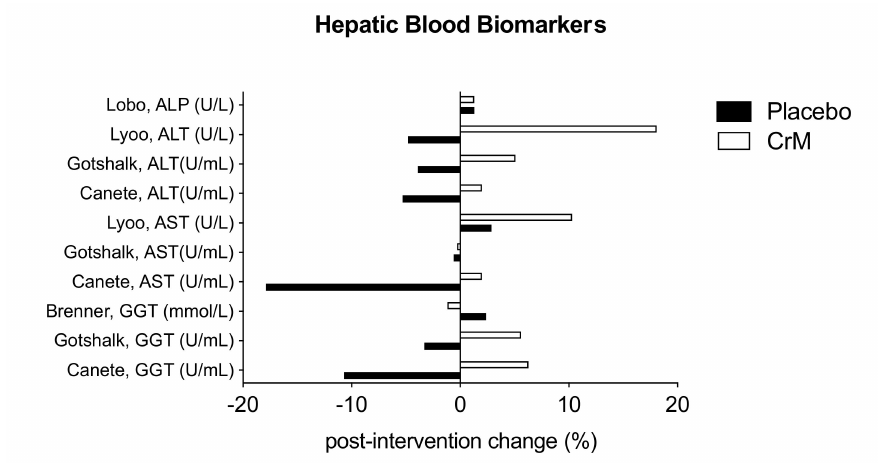
Figure 7. Changes in hepatic blood biomarkers within placebo (solid bar) and CrM (hatched bar) groups. Data are presented as % change pre- to post-intervention. Units are expressed as presented in the original manuscripts. ALP = alkaline phosphatase; AST = aspartate aminotransferase; ALT = alanine aminotransferase; GGT = gamma glutamyl